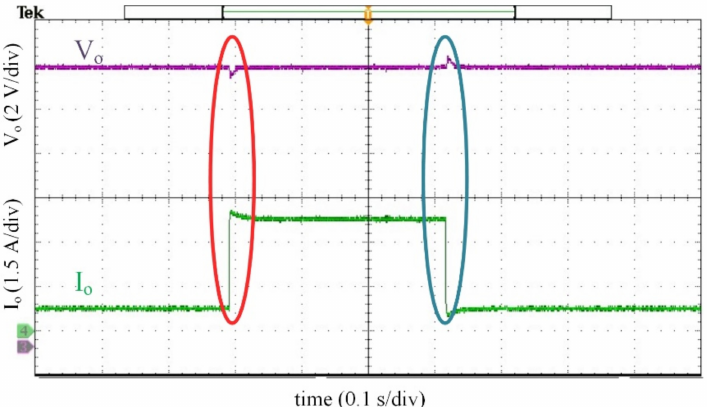
Figure 10. V o and I o waveforms of the DSBFC (V o = 12.6 V) when the output current changes.